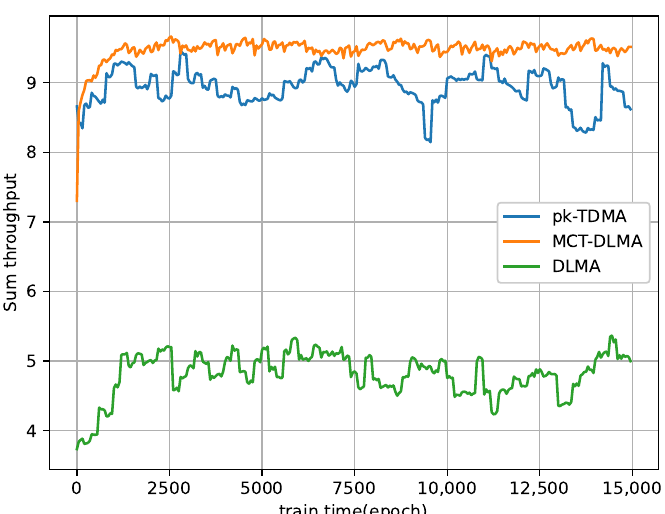
Figure 6. Sum throughput when CU coexists with 10 dynamic TDMA